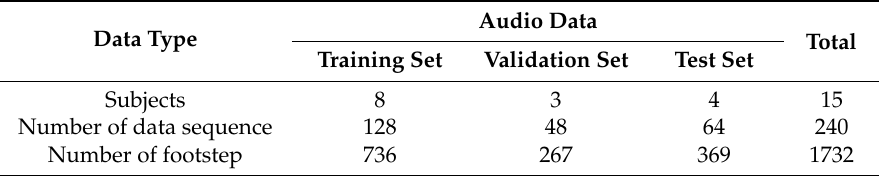
Table 3. Data structure for the